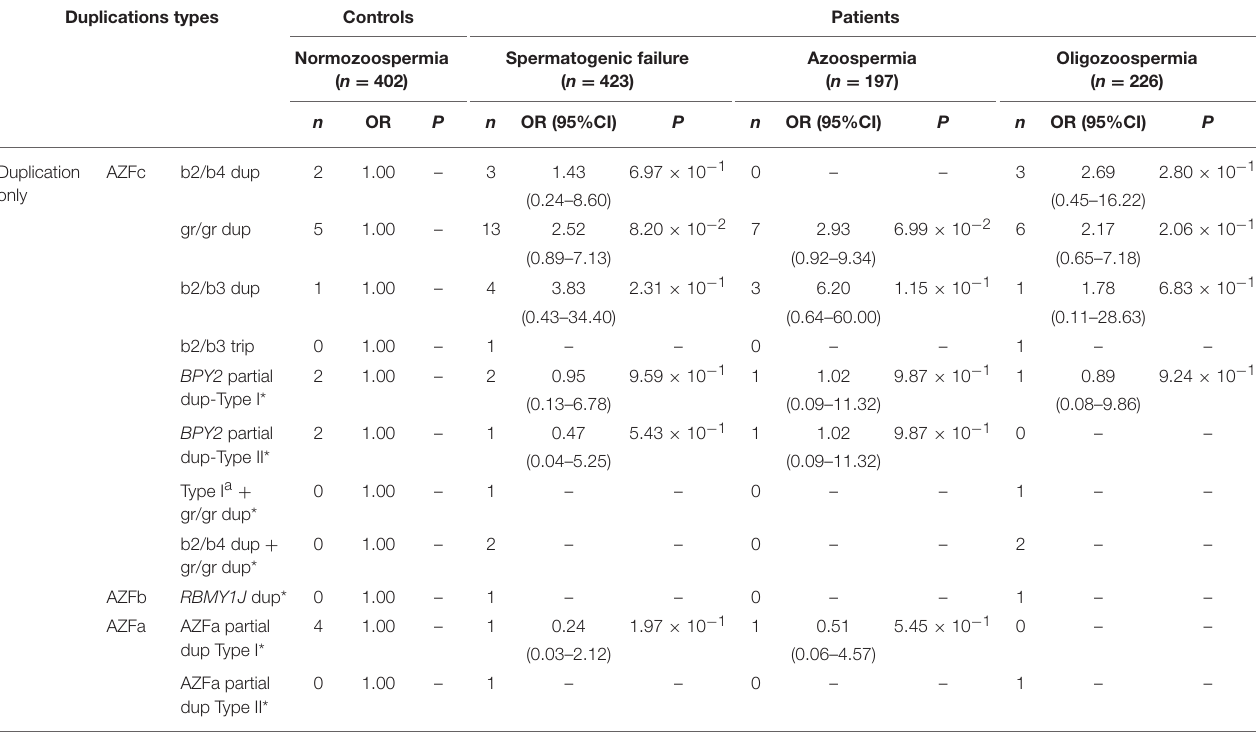
TABLE 3 | Distribution of known and novel duplications in AZF regions and their effects on SF. Duplications types